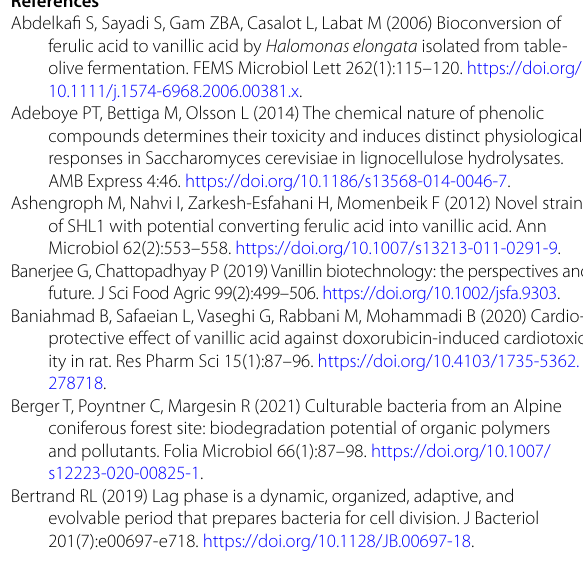
0.05) between vanillin concentrations ≤